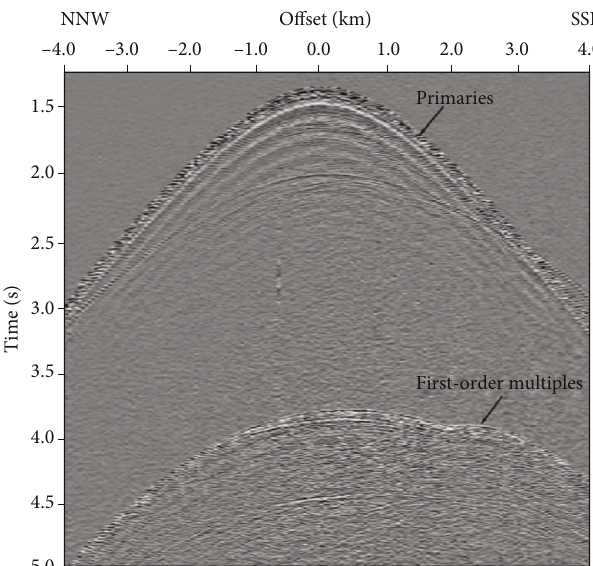
Figure 3: The hydrophone component of OBS6. The arrows indicate the primary and multiple